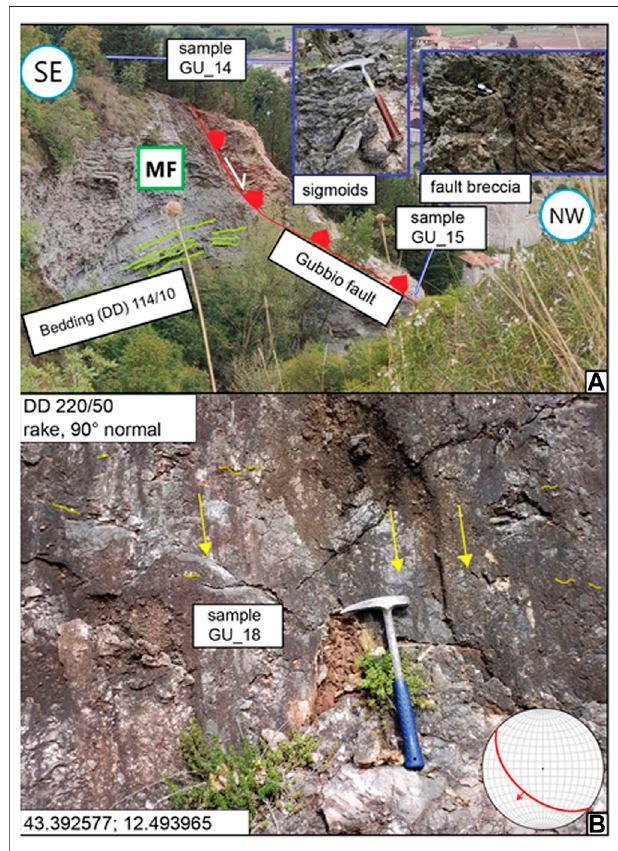
FIGURE2| Fieldsitessampledinthiswork: (A) Gubbiolocality(GL),and (B) detail of the Mocaiana locality (ML). DD stands for “ Dip Direction ” notation. MFstandsfortheMarneaFucoidiFormation.Inthetoppanel(A),thelocations of GU_14 (sigmoids) and GU_15 (fault breccia) are shown. The bottom panel (B) shows the location of sample